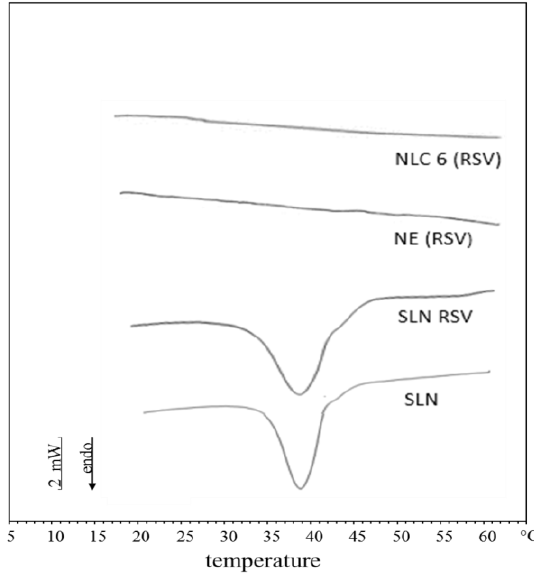
Figure 3. Calorimetric curves, in heating mode, of the following lipid nanocarriers: unloaded SLN (SLN); 1% w / w RSV loaded SLN (SLN RSV); unloaded NE [NE (RSV)] and 1% w / w RSV loaded NE [NE (RSV)] curves are overlapping; unloaded NLC6 [NLC6 (RSV)] and 1% w / w RSV loaded NLC6